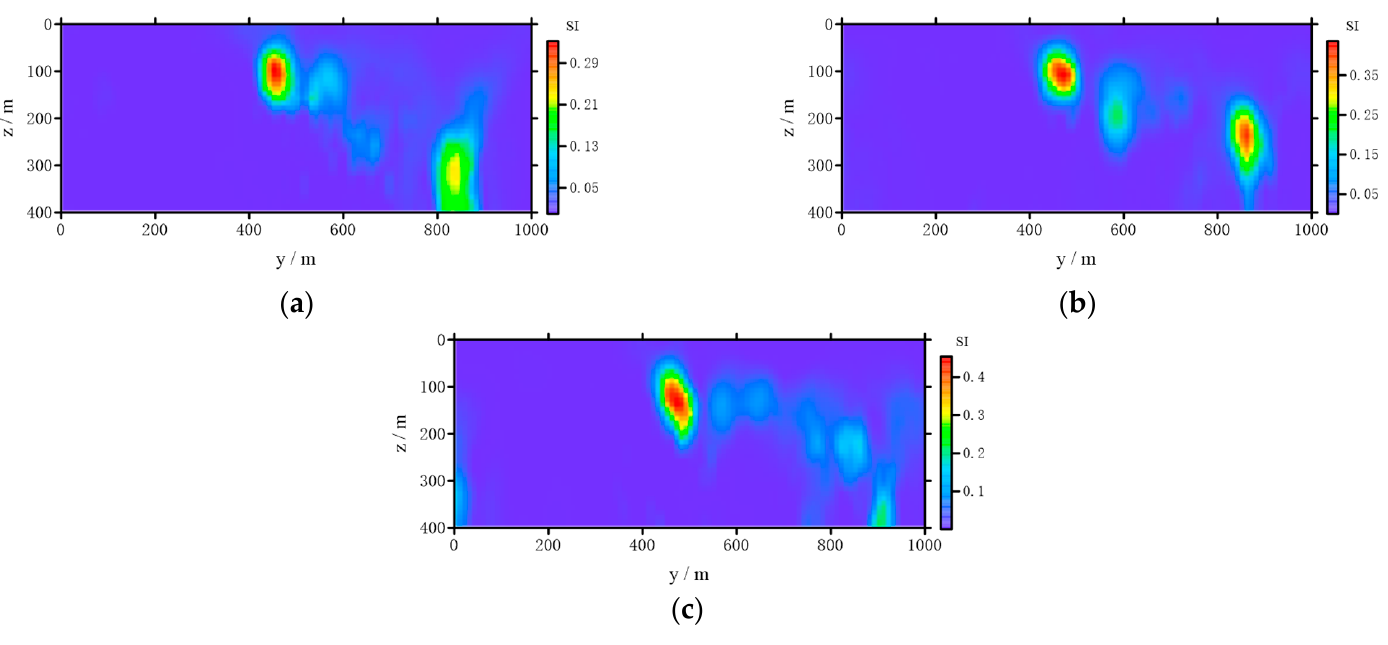
Figure 17. The susceptibility image of ∆ T for line L with different susceptibility constraints in the Zaohuoxi area. ( a ) χ max = 0.37 SI , ( b ) χ max = 0.74 SI , ( c ) χ max = 1.21 SI .